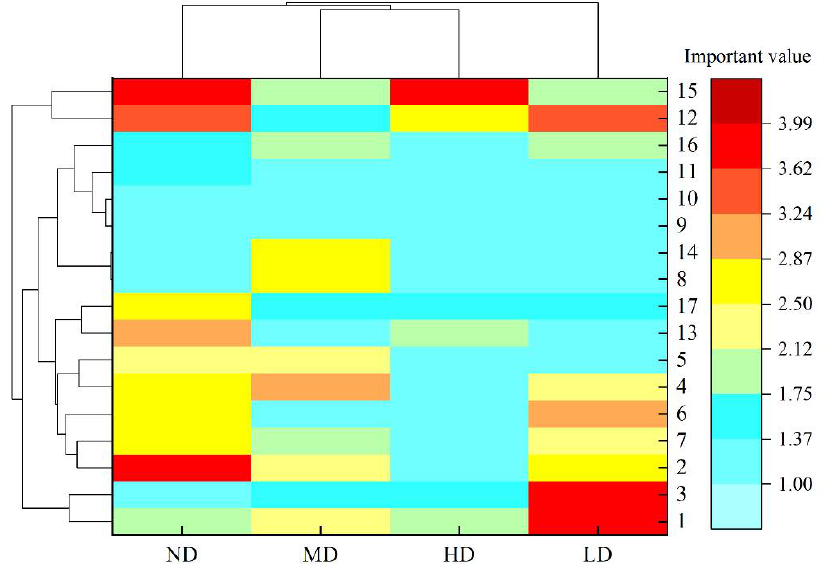
Figure 5. Correlation analysis of important values of main plants in the sandy area of Qinghai Lake Basin. ND stands for not desertification, LD for light desertification, MD for moderate desertification, HD for heavy desertification. See Table 1 for the meanings of species numbers.